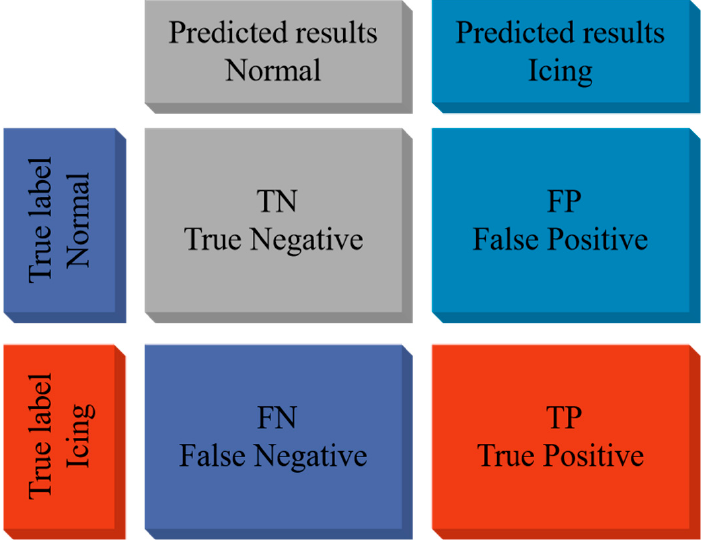
Figure 5. Confusion